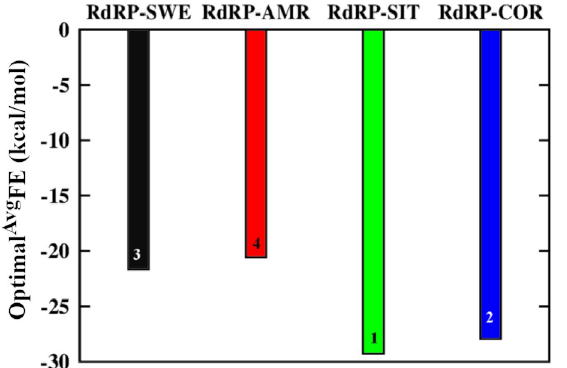
Fig 5. Free energy of binding of phytochemicals. Optimal average of free energy of binding between the phytochemicals SWE (black), AMR (red), SIT (green) and COR (blue) and RdRP protein.